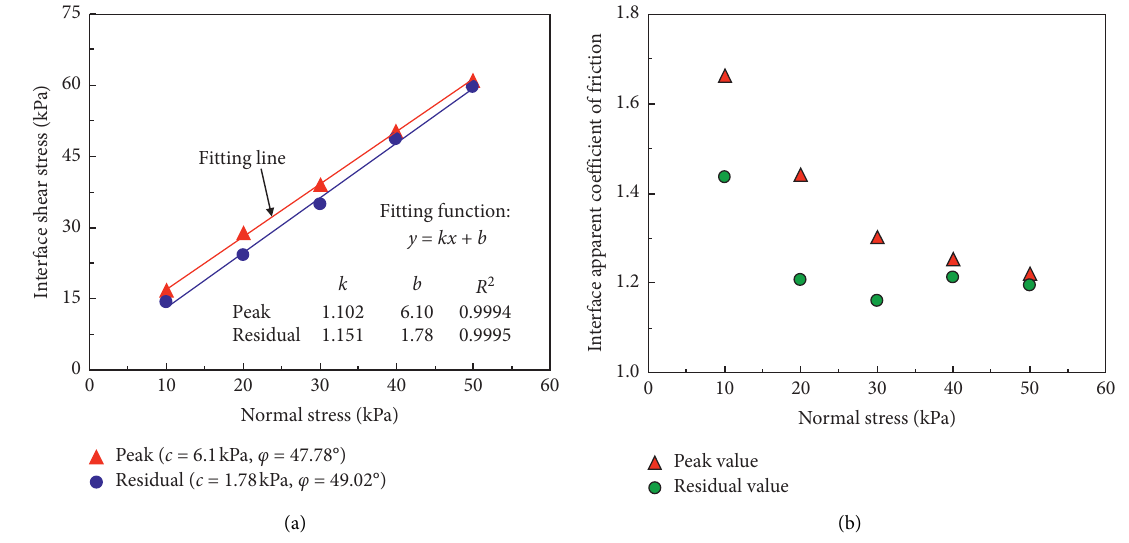
Figure 9: Interface parameters. (a) Interface strength. (b) Apparent coefficient of